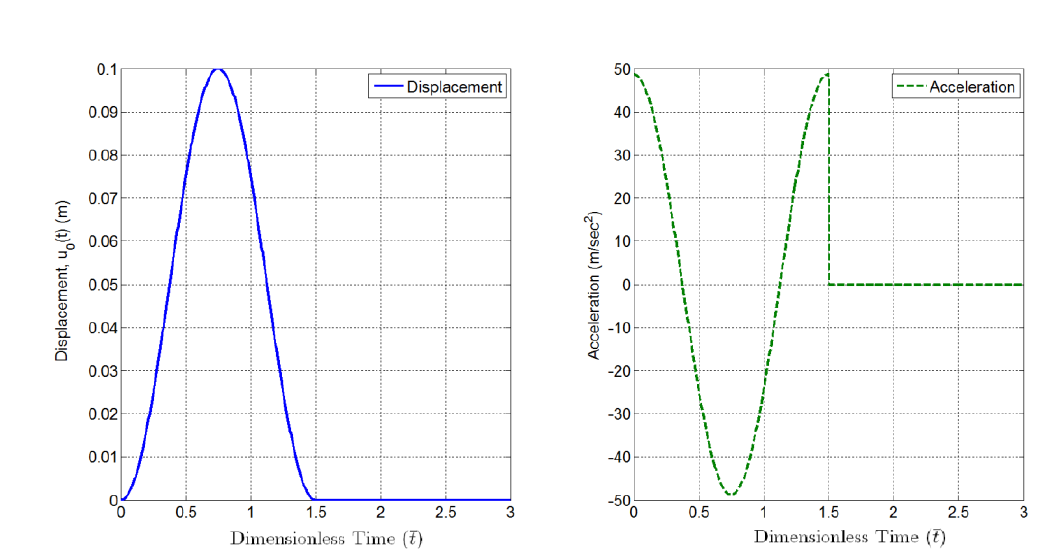
Figure 5. Input Displacement and acceleration time histories.